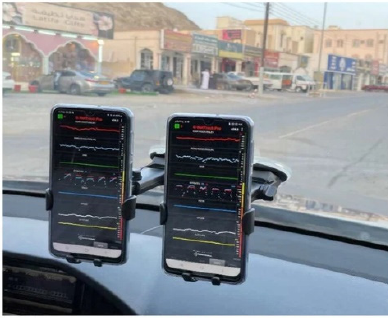
Figure 4. Smartphones mounted in moving vehicles during drive test [40].